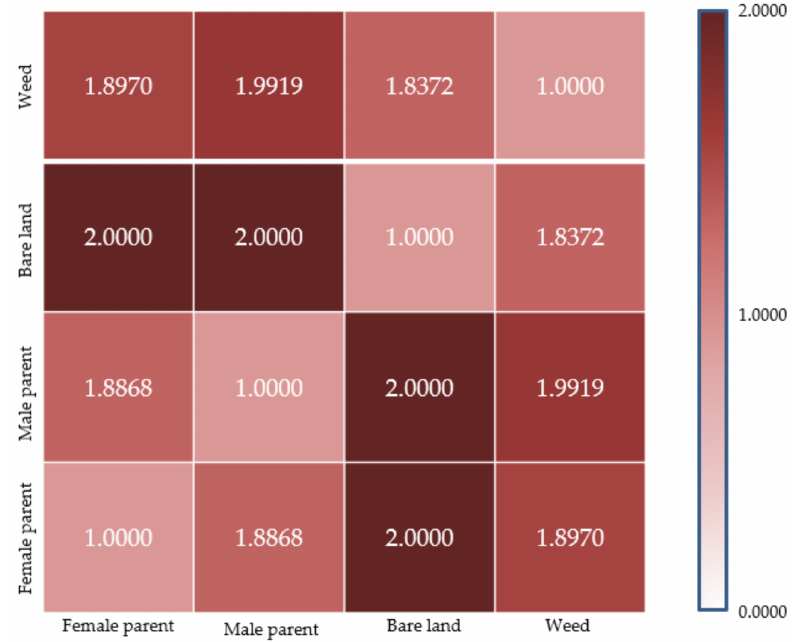
Figure 2. Separability of four types of ground feature samples.